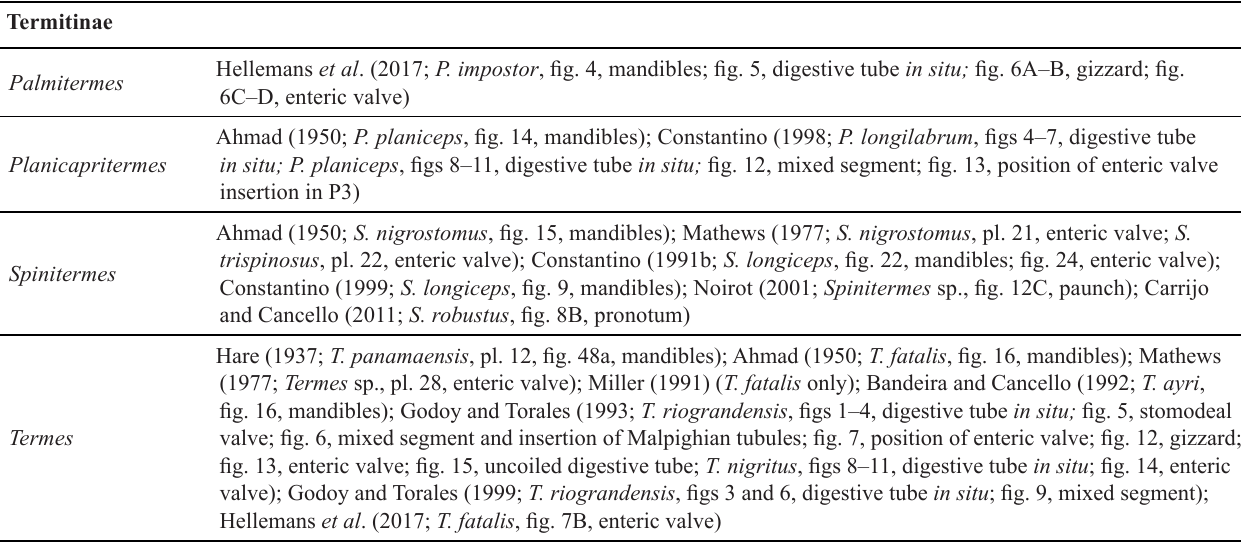
Table 1. List of taxonomic studies that treat the worker caste of Neotropical Termitidae genera. (Continuation)